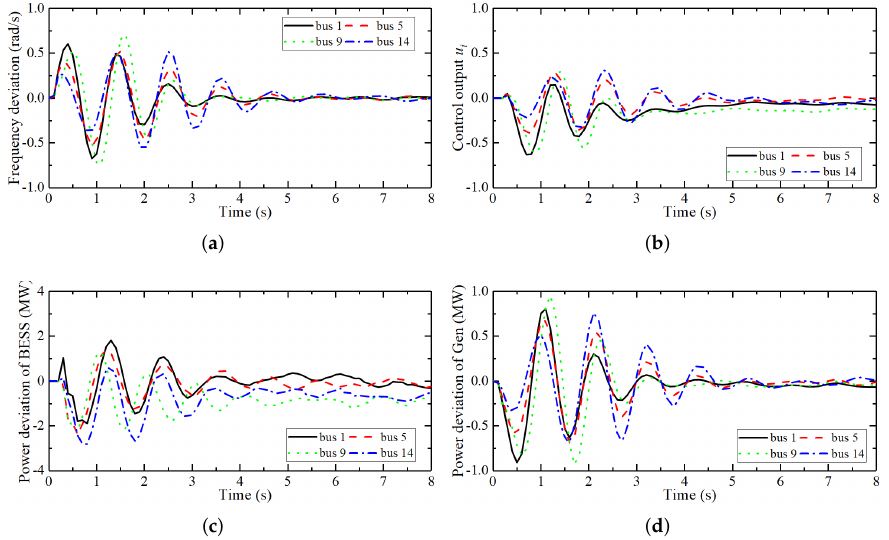
Figure 8. Frequency deviation, control output, BESS and power output deviation of the generator in IEEE14 bus testing system, η ji = 0.1. ( a ) Frequency deviation. ( b ) Control output u i . ( c ) Power deviation of BESS. ( d ) Power deviation of